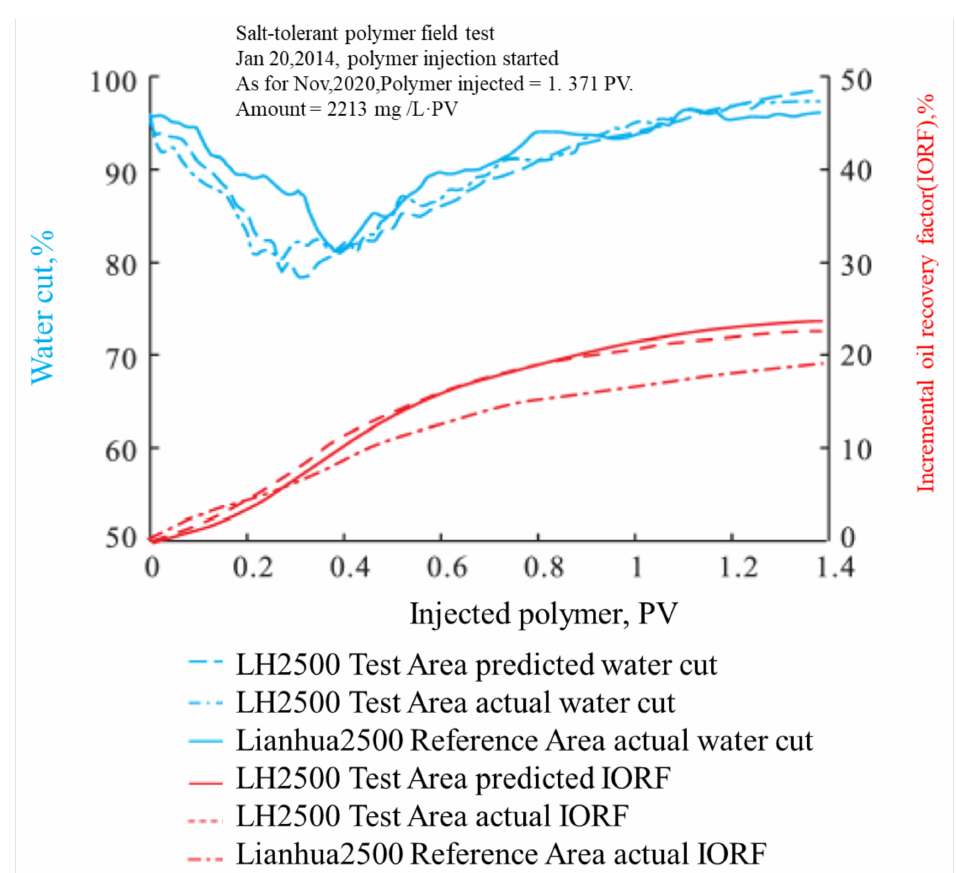
Figure 15. Polymer-flooding performance (revised from